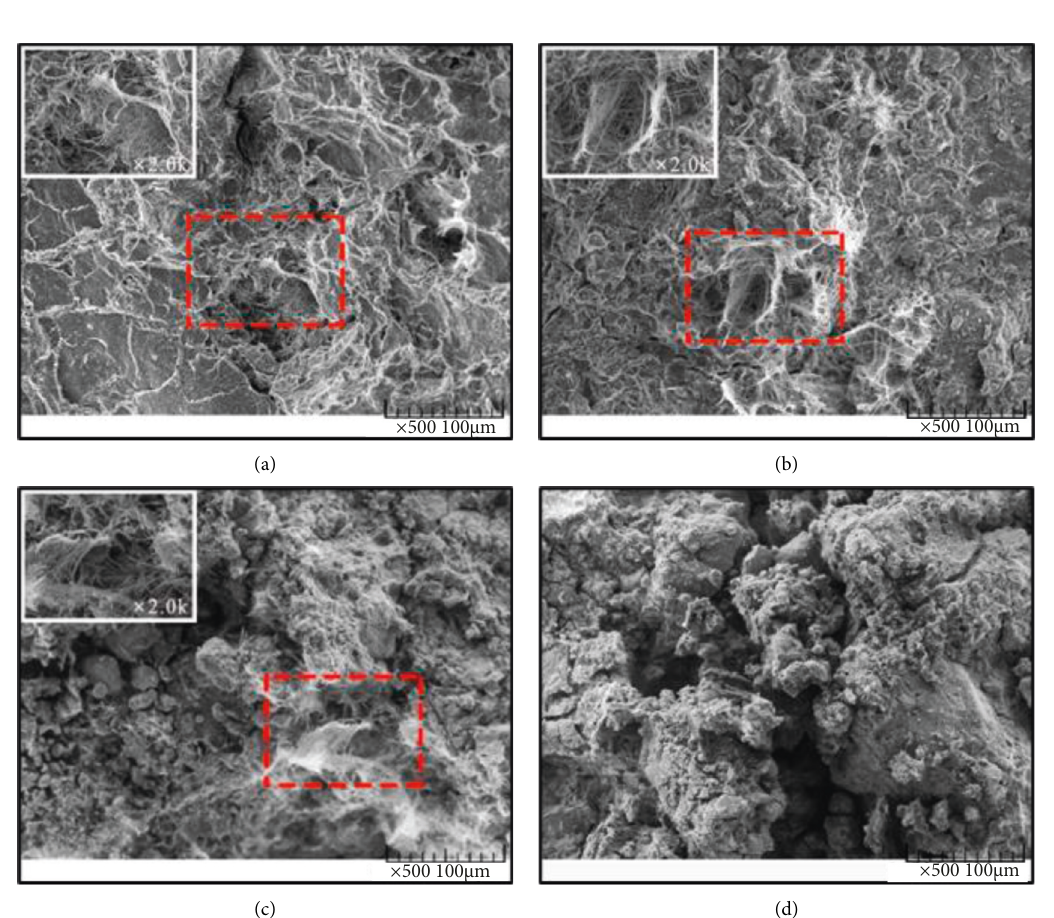
Figure 7: Microstructure images of different samples. (a) HA content λ � 0%. (b) HA content λ � 10%. (c) HA content λ � 20%. (d) HA content λ �